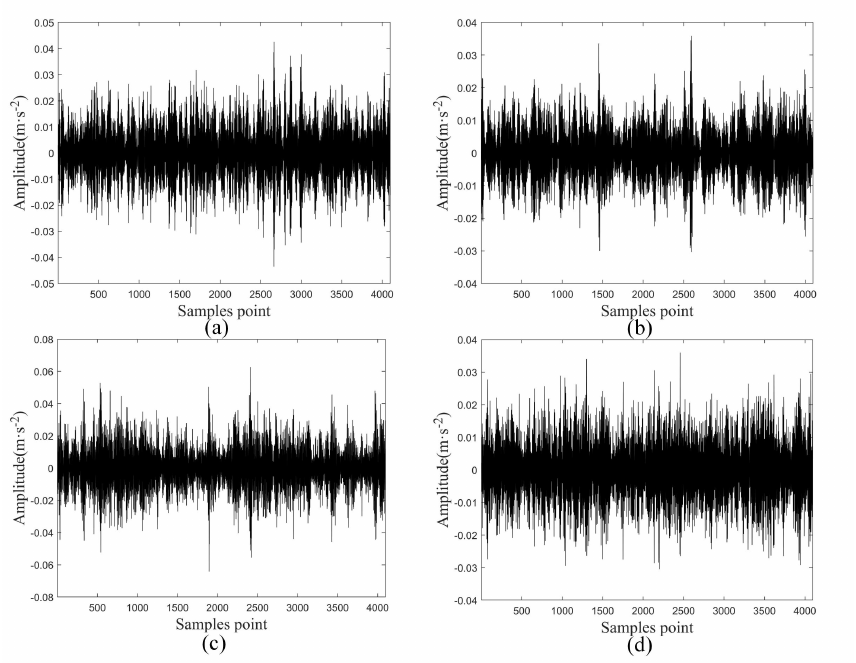
Figure 13. Reconstructed signal time domain waveform of the ER–12K rolling bearing in 4 states: ( a ) Inner race fault, ( b ) Outer race fault, ( c ) Rolling element fault, ( d ) Normal